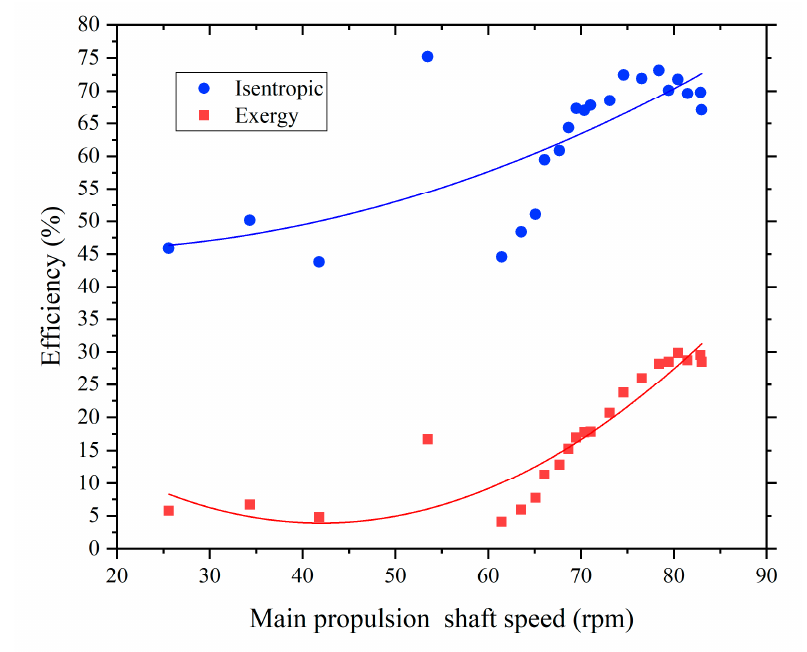
Figure 9. Isentropic and exergy e ffi